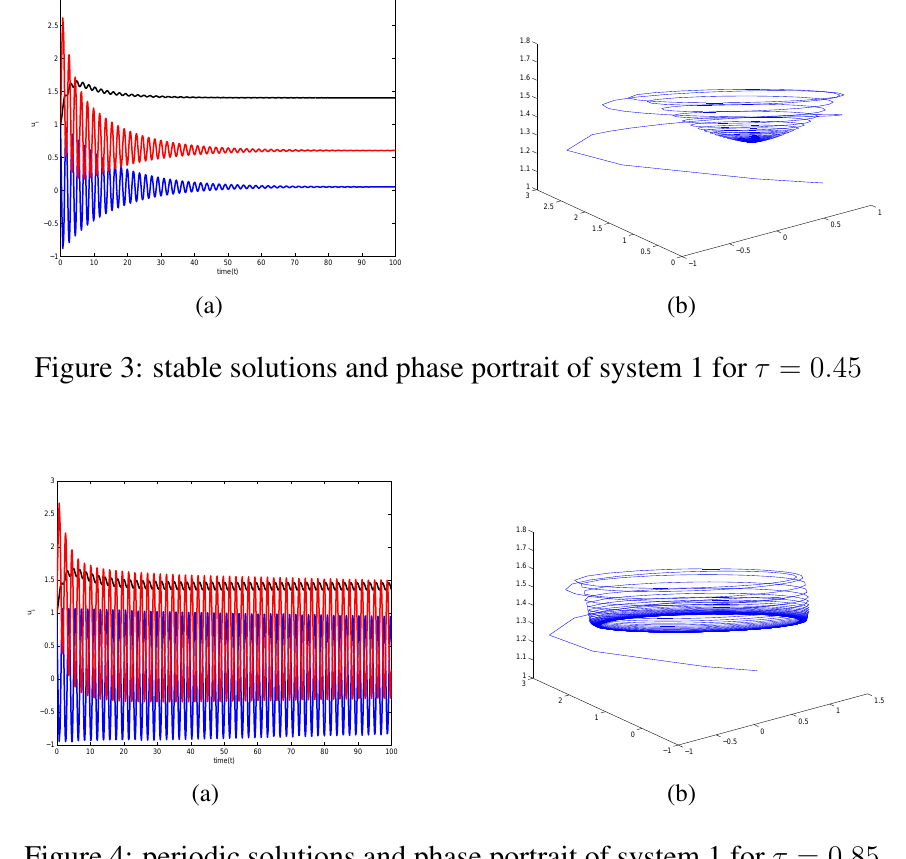
Figure 4: periodic solutions and phase portrait of system 1 for τ = 0 .